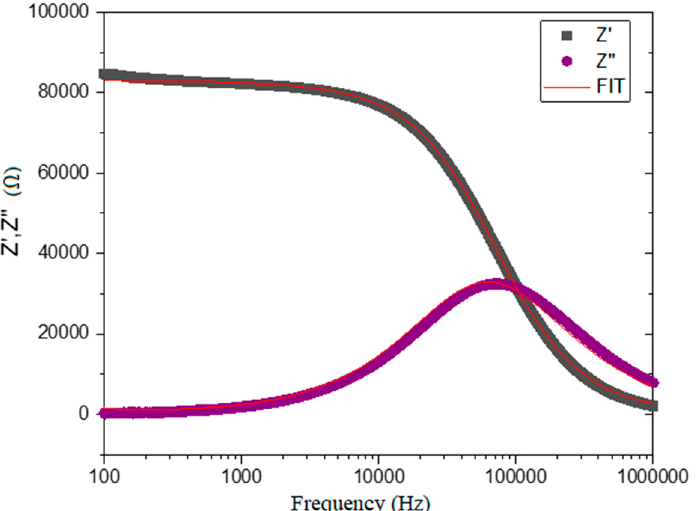
Figure 6. Experimental and theoretical impedance diagrams of the sample TZV5 at the temperature T = 280 °C.